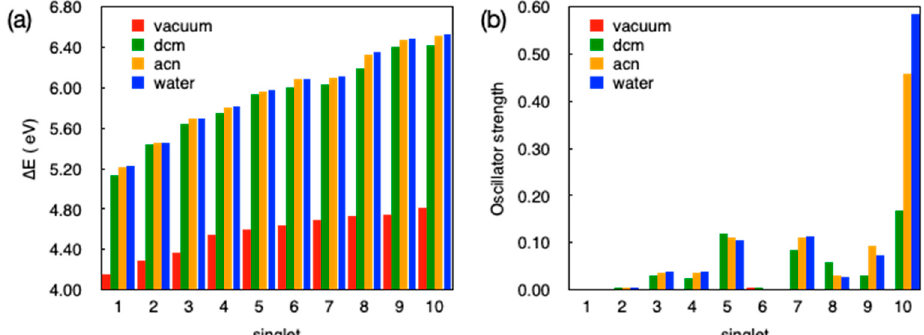
Figure 8. Vertical transition energies ( a ) and oscillator strengths ( b ) for the 10 lowest excited singlet states S 1 –S 10 of the isolated ligand L − in vacuum and in different solvents. The geometry of the ligand corresponds to that found experimentally for 1 .